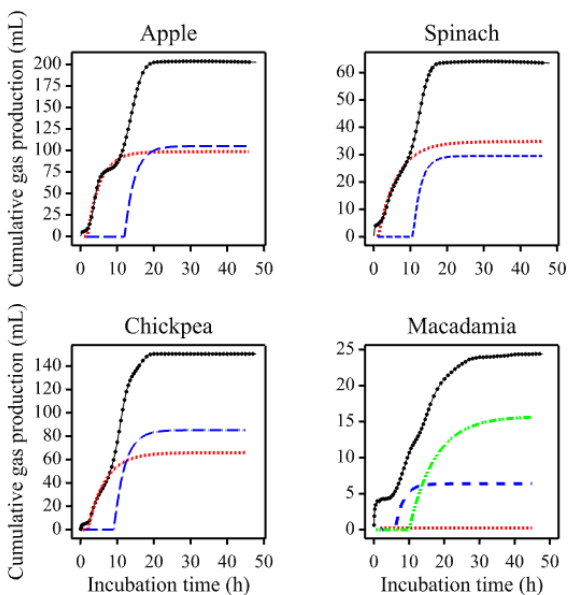
Figure 2. Examples (apple, spinach, chickpea, and coarsely ground macadamia) of fitting multiple Mitscherlich terms to multiphasic gas production profiles generated using porcine fecal inocula [15,16]. The figure panels show the overall fit (solid line), resolved components (broken lines), and hourly data points (dots).